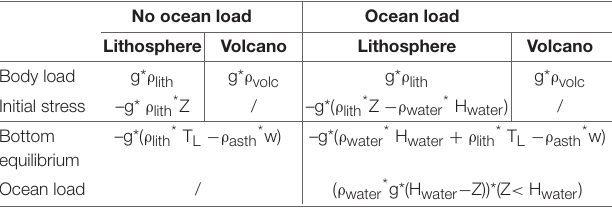
TABLE 2 | Boundary conditions of the initial finite element models (FEM), where w is the vertical displacement, g is the Earth’s gravitational acceleration; ρ lith , ρ asth and ρ water are the lithosphere, asthenosphere and water densities, respectively, H water is the water height, T L is the thickness of the lithosphere, Z represents the depth of any point of the initial geometry (negative